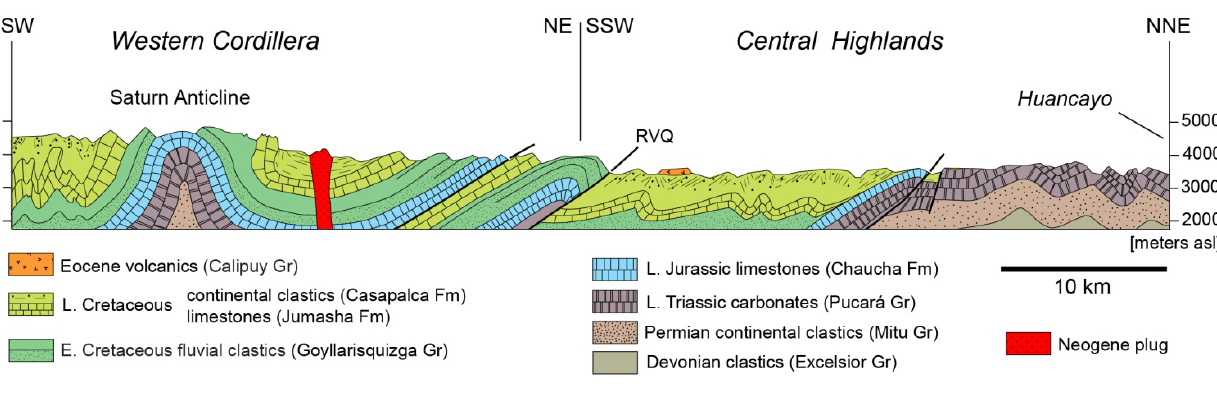
Figure 10. Cross-section of the Central Highlands and the adjacent Western Cordillera between Huancayo and Tomas (see Figure 7 for location). Folds are more open in the Central Highlands. RVQ: Raura–La Viuda–San Jose de Quero